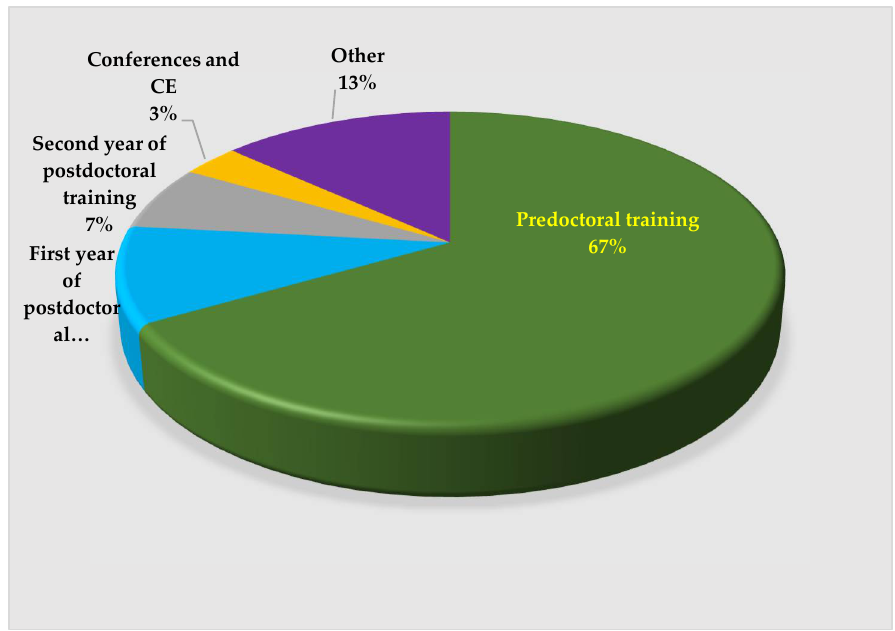
Figure 2. Residents’ recall of first learning about MIH. Table 1. Association between the line of specialty and level of confidence in identifying MIH.